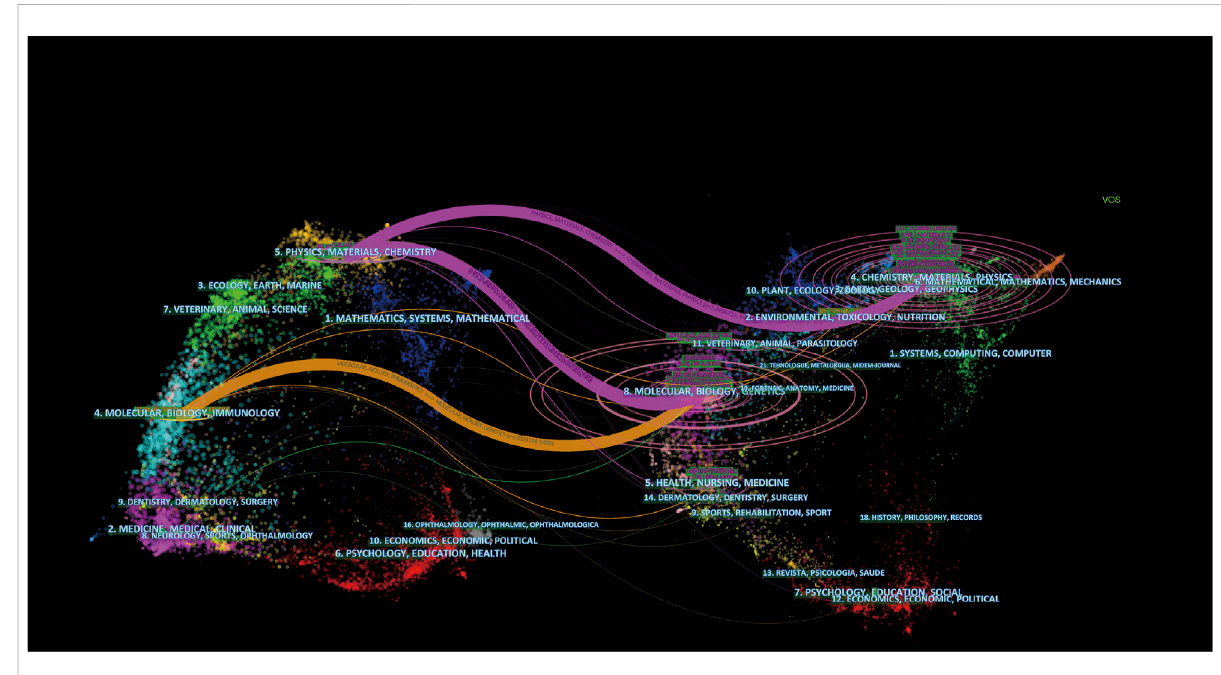
FIGURE 10 The dual-map overlay of journals related to the top 100 most cited references in Nanoparticles-leukemia research. Notes: The citing journals were on the left, the cited journals were on the right, and the colored path represents the citation